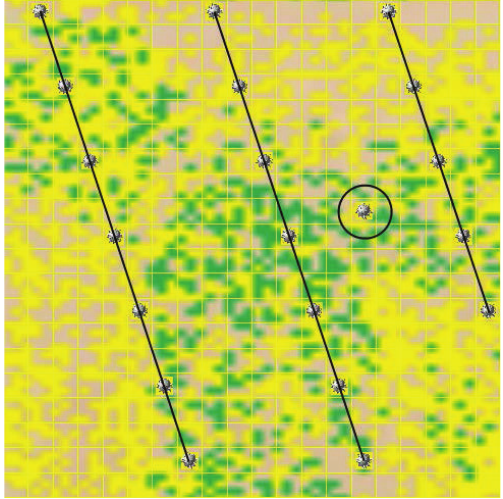
Figure 5: Pattern-based mine distribution in a 20 × 20 minefield.